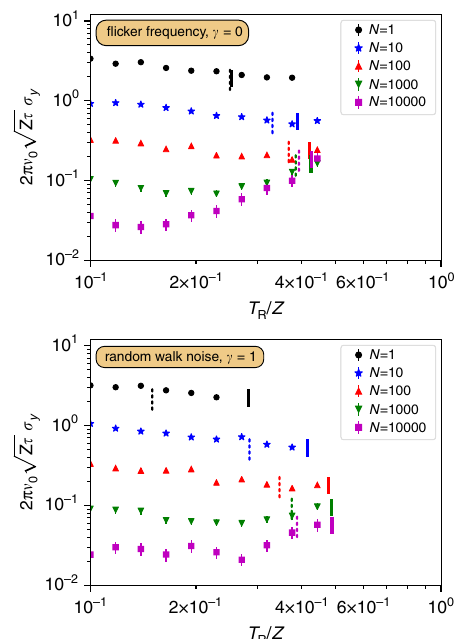
Fig. 5 Modeling fringe-hops. Numerically simulated dimensionless clock instability σ y (symbols) as a function of the Ramsey time T R / Z for a comparison to the predicted onset of fringe-hops, based on a mean fi rst escape time (solid bars), as well as the safe interrogation times (dashed bars) suggested by Eq. (37) and (38). For both, fl icker frequency noise and random walk of frequency noise, we fi nd that the predictions based on the mean fi rst escape time reproduce the observed sudden increase in instability well. To include different noise strengths, we normalized all time scales to the laser coherence time Z (see main text). Error bars are one standard deviation from a fi nite size averaging in the numerical